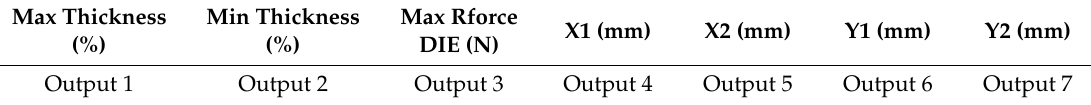
Figure 6. Definition of output variables: X1, X2, Y1 and Y2 and related detail of X1. Table 2. Output variables list.